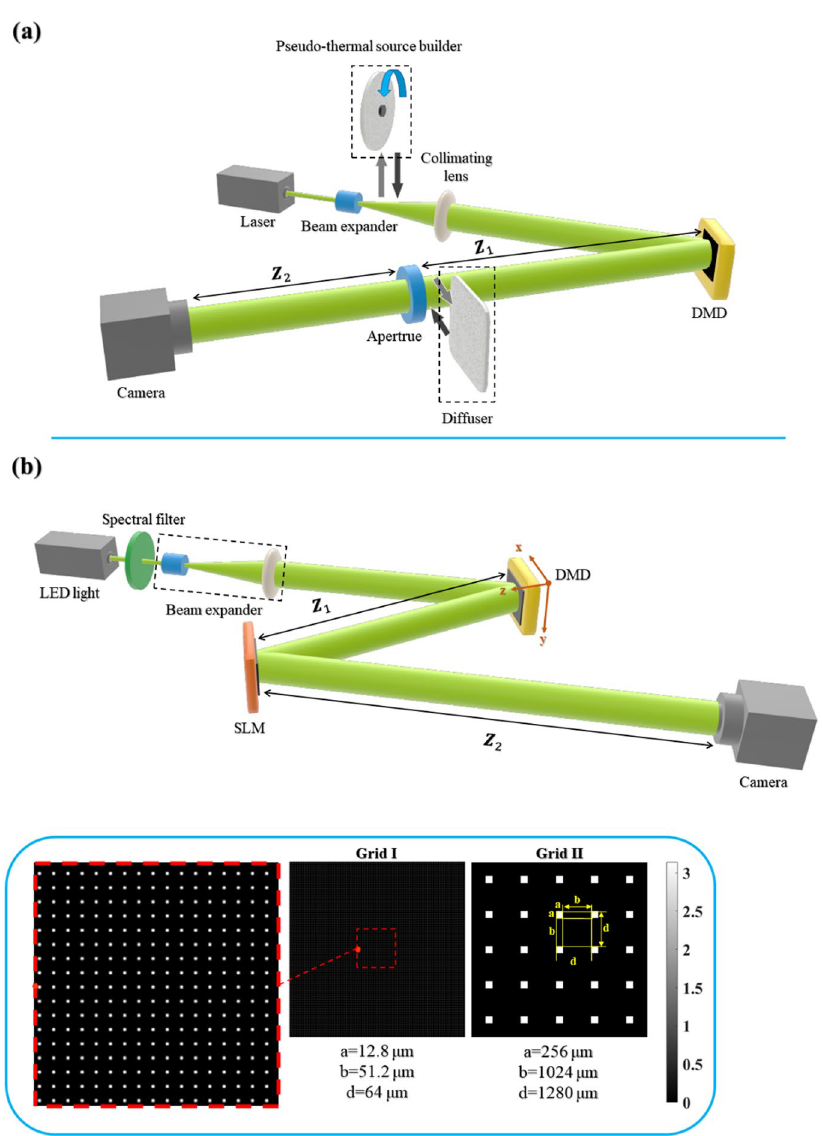
Fig. 1 Schematics of experimental setup. a Experimental setup to validate different channels in a scattering medium. The switch of channels is realized by inserting a rotating diffuser and a stationary diffuser into the optical path. b Experimental setup to demonstrate no valid channels in phase-grids, although they constitute shift-invariant systems and can convey light energy to the camera. The lower row shows the structures of the two phase-grids loaded on the SLM. d is the cell period, and a is the width of the phase square with a value of π in each cell. The color bar on the right denotes the phase value. The insert on the left is the zoom-in of the dash red square. Abbreviations: DMD - digital micromirror device; SLM - spatial light